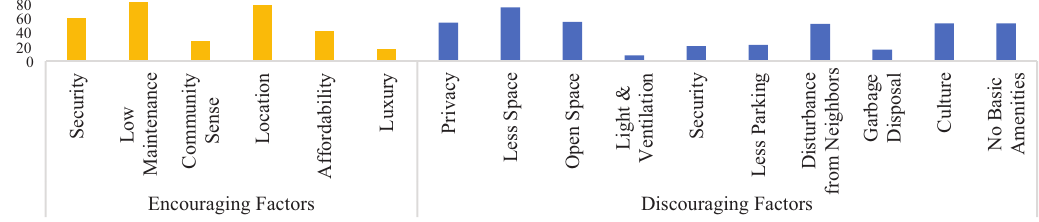
Figure 13. Factors affecting the preference of residents regarding apartment buildings (source: filed